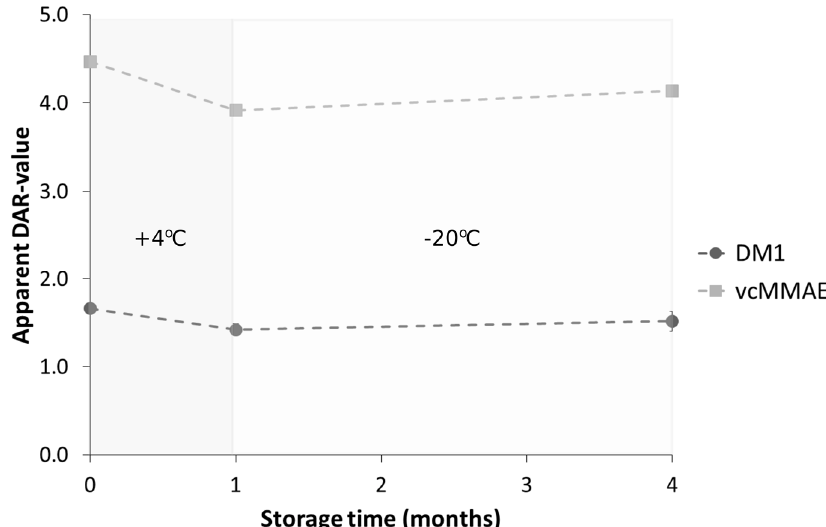
Figure 6. Dependence of apparent DAR-values on storage of ADC samples in case of delayed analyses. The apparent DAR-values for one single batch of either cysteine-linked (vcMMAE) and lysine-linked (DM1) ADC, as determined by RPLC–MS, changed over time from storage at 4 ◦ C for 1 month (decrease in apparent DAR-values) followed by − 20 ◦ C storage for an additional 4 months (increase in apparent DAR-values). All samples were stored in phosphate-bu ff ered saline (PBS) solution at 1- µ g / µ L protein concentration. Error bars depict the standard deviation from triplicate measurements for each sample.